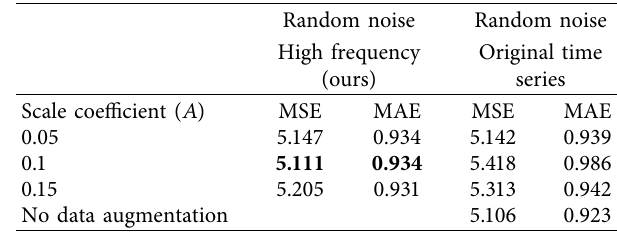
Table 2: Comparison experiments by adding random noises with diverse scales over both the high-frequency subseries and original time series.